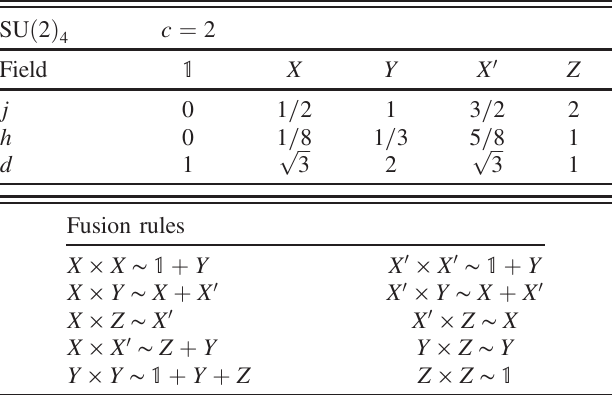
TABLE II. Properties of SU ð 2 Þ 3 and SU ð 2 Þ 1 topological quantum field theories that describe the descendant phase on the left side of Fig. 10. In the table, c is the chiral central charge, j is an SU(2) spin label, h denotes conformal spin, d represents the quantum dimension, and φ is the golden